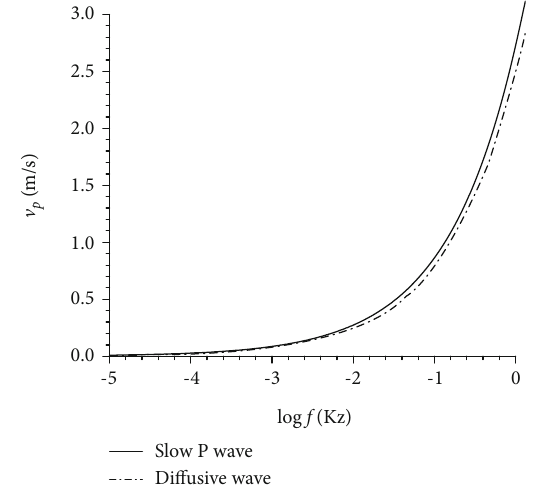
fl uid pressure wave in Biot Figure 5: Theoretical velocity ( v p ) of [11] theory, for water saturated Berea sandstone and with f denoting